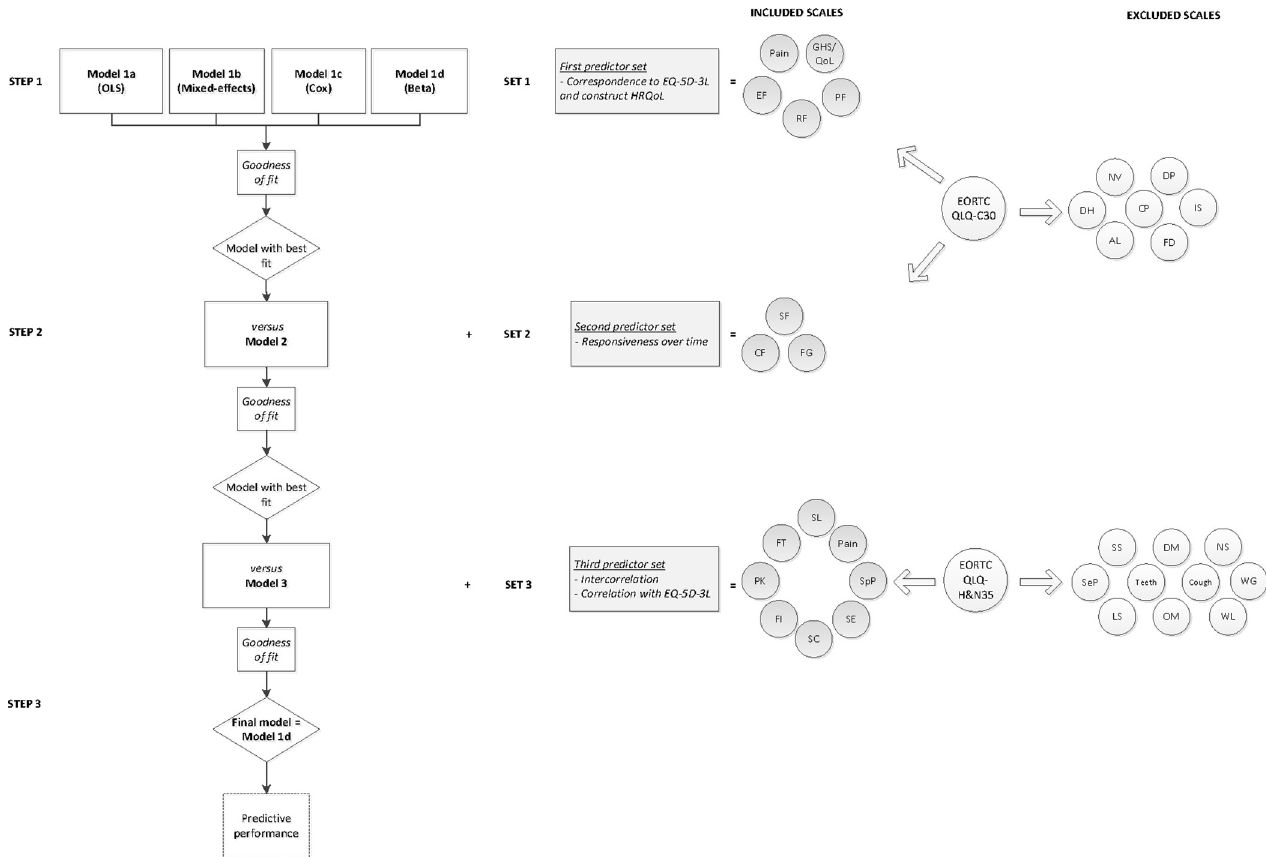
Fig 1. Flowchart of model development. The grey rectangles display the three predictor sets with their criteria; the white rectangles the different models. The squares indicate the assessment of the models during model comparison; the rhombuses indicate the decision-making in the process. Assessment of the model performance is displayed with a dotted line. The EORTC QLQ-C30 and QLQ-H&N35 scales included in the predictor sets are highlighted in grey circles. The scales that were excluded are colored white. Abbreviations: AL, appetite loss; Cough, coughing; CF, cognitive functioning; CP, constipation; DH, diarrhea; DP, dyspnea; DM, dry mouth; EF, emotional functioning; EORTC, European Organization for Research and Treatment of Cancer; EQ-5D-3L, three-level EuroQol five-dimensional questionnaire; FD, financial difficulties; FG, fatigue; FI, felt ill; FT, feeding tube; GHS/QoL, global health status/quality of life; HRQoL, health- related quality of life; IS, insomnia; LS, less sexuality; NT, nutritional supplements; NV, nausea and vomiting; OLS, ordinary least-squares, OM, opening mouth; PF, physical functioning; PK, pain killers; Quality of Life Questionnaire-Core 30; QLQ-H&N35, Quality of Life Questionnaire-Head and Neck35;